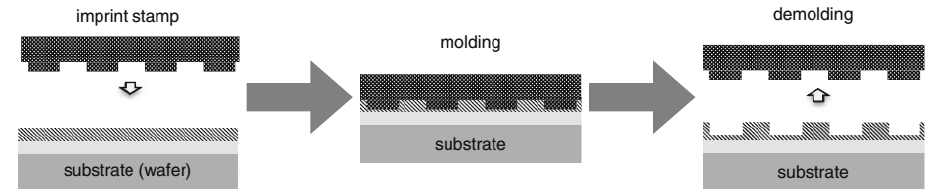
Figure 13. Nano imprint lithographic stamp applied to a polymer layer. After polymer solidification, a template that is equivalent to that of a photoresist mask is formed as shown in the final step after demolding (Adapted with permission from [107], Springer,